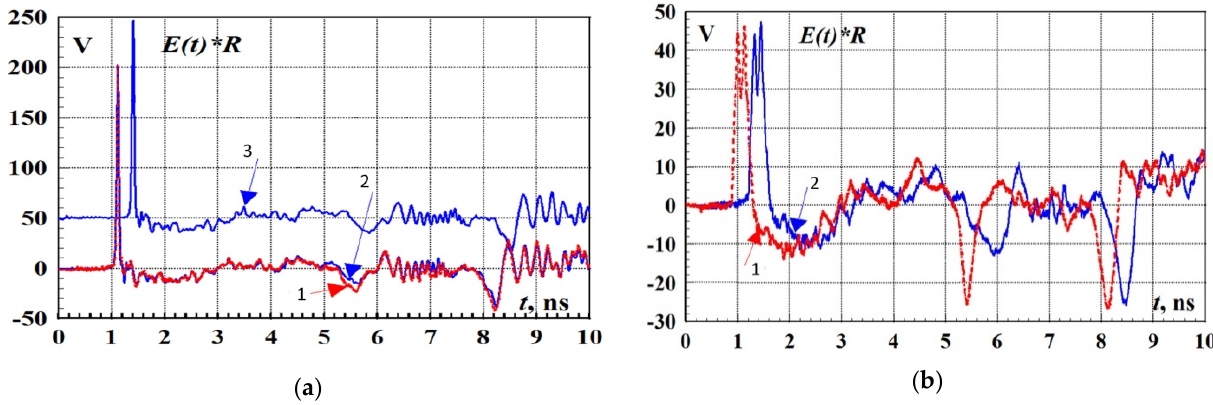
Figure 9. Radiation potential E ( t ) R for the radiator, exited by the TMG40R test generator with different antennae (antenna A16 or stripline StF4) for different angles (0 ◦ or 30 ◦ ) in the H -plane. ( a ) For 1, StF4 is the radiator, and A16 is the receiver (the axes match). For 2, A16 is the radiator, and StF4 is the receiver (the axes match). For 3, A16 is the radiator, and StF4 is the receiver (the axis of StF4 was deflected by 30 ◦ from axis of the R A–S ). ( b ) The axis of A16 was deflected by 30 ◦ from axis of the R A–S . For 1, A16 is the radiator, and StF4 is the receiver. For 2, StF4 is the radiator, and A16 is the receiver.